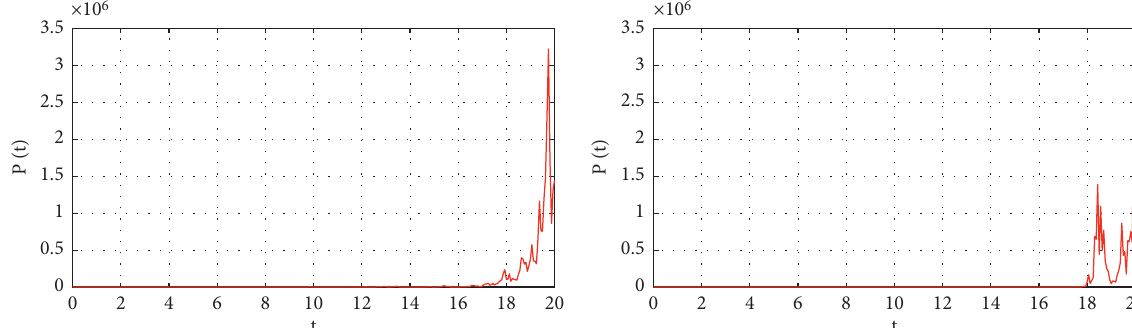
Figure 1: The trajectories of system (91) with P � 1 ,H � 0 . 3. (a) θ � 1 ,u � 1 ,v � 1. (b) θ � 1 , u � 1 ,v � 2. The trajectories of system (91) 0 are almost surely exponentially unstable for both (a) and (b) in the sense of Theorem 5 (i).